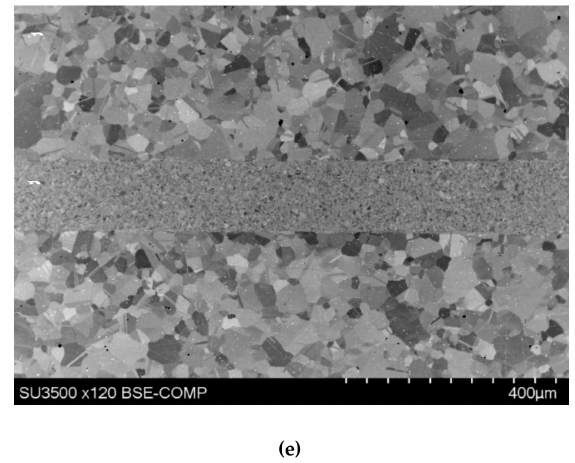
Figure 6. SEM images of ( a ) bondline 9, ( b ) bond 9 base material, ( c ) bondline 12, ( d ) bond 12 base material, and ( e ) bond 4 showing variation in grains from bondline to base material.